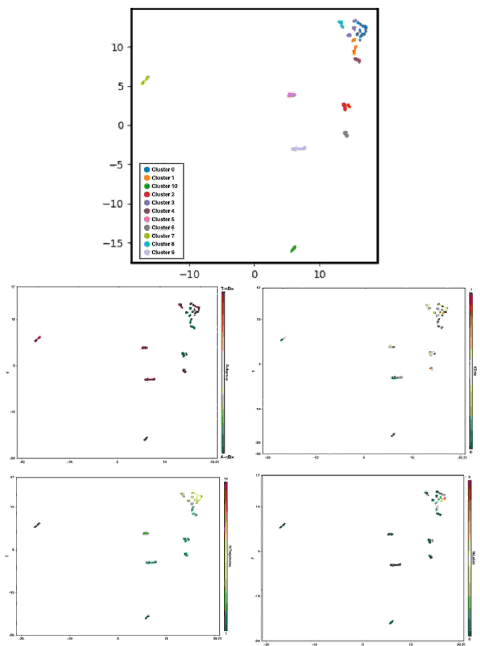
Figure 5. Graph-based clustering and subcomponent analysis (CST tractography availability, nor- malized time to perform the planning, number of trajectory and lobe changes) according to uniform manifold approximation and projection.